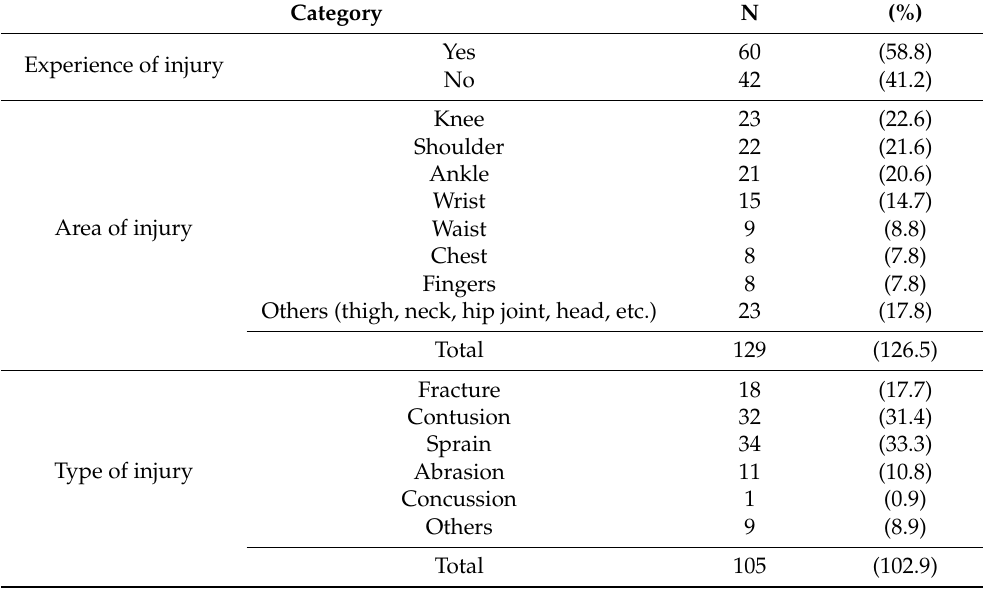
Table 3. Injury Information of Participants.